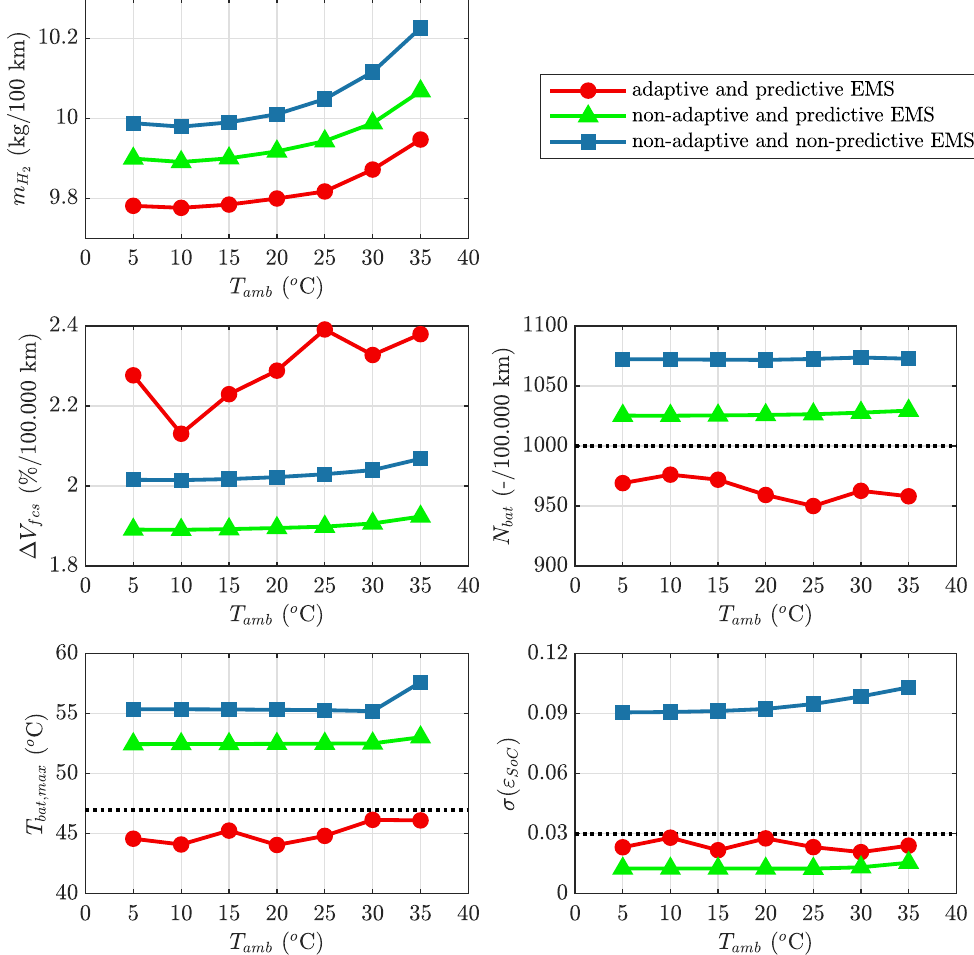
Figure 13. Comparison of KPIs between the adaptive and predictive EMS versus the non-adaptive and non-predictive strategies at different ambient